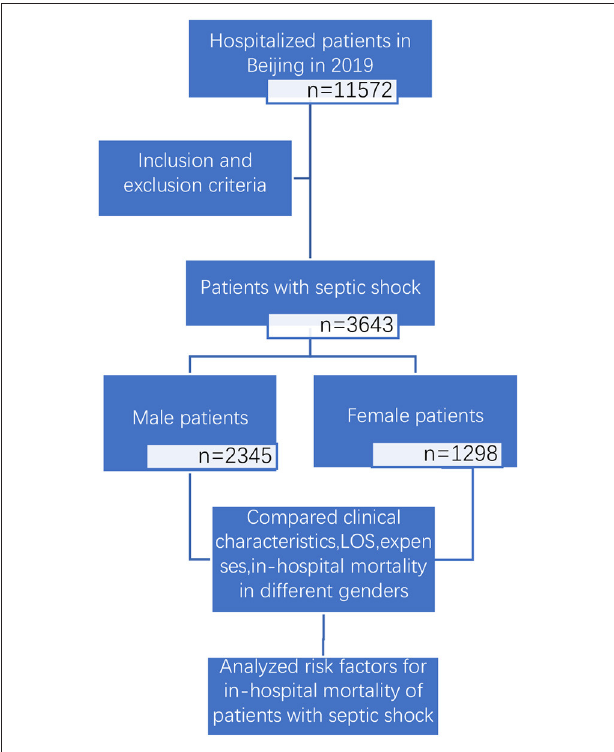
FIGURE 1 | The study flow